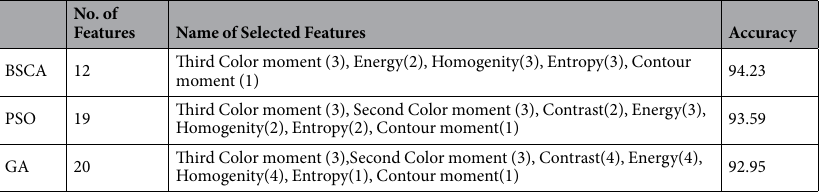
Table 2. The selected features and their accuracy.